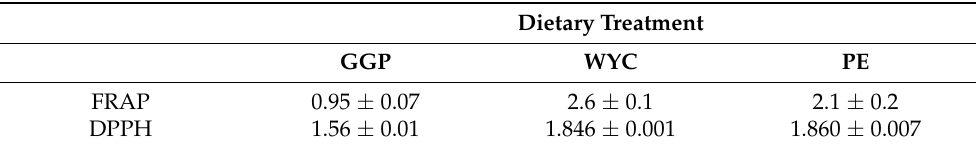
Table 2. The total antioxidant capacity of grape pomace (GGP), dried wine lee extract (WYC), and grape stem extract